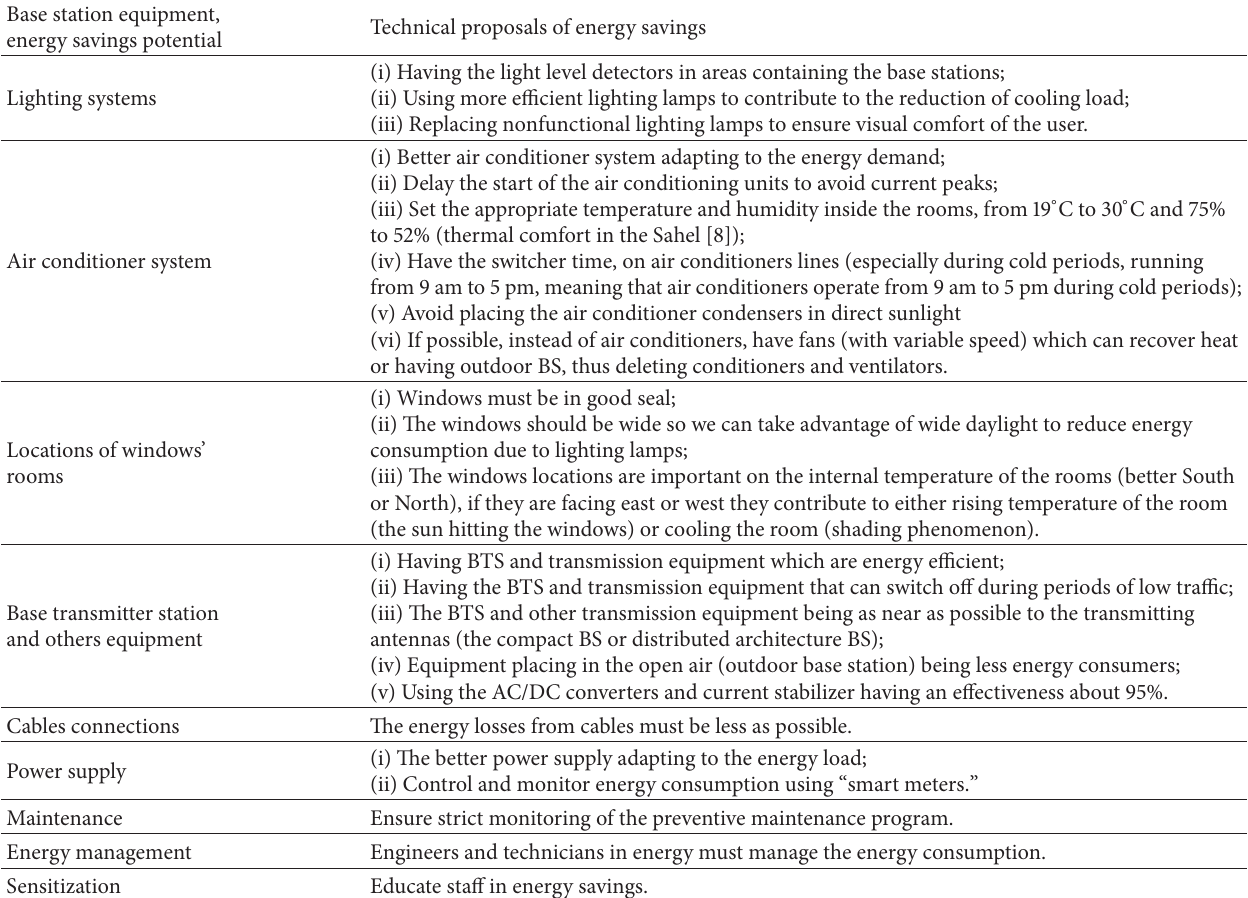
Table 11: Techniques of solutions of energy